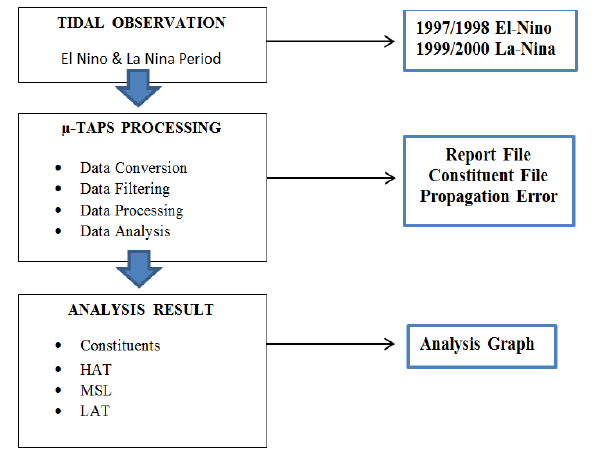
Figure 2. Flow chart of tidal processing using µ-TAPS Software to define characteristics of tidal pattern during El- Nino and La-Nina Phenomena